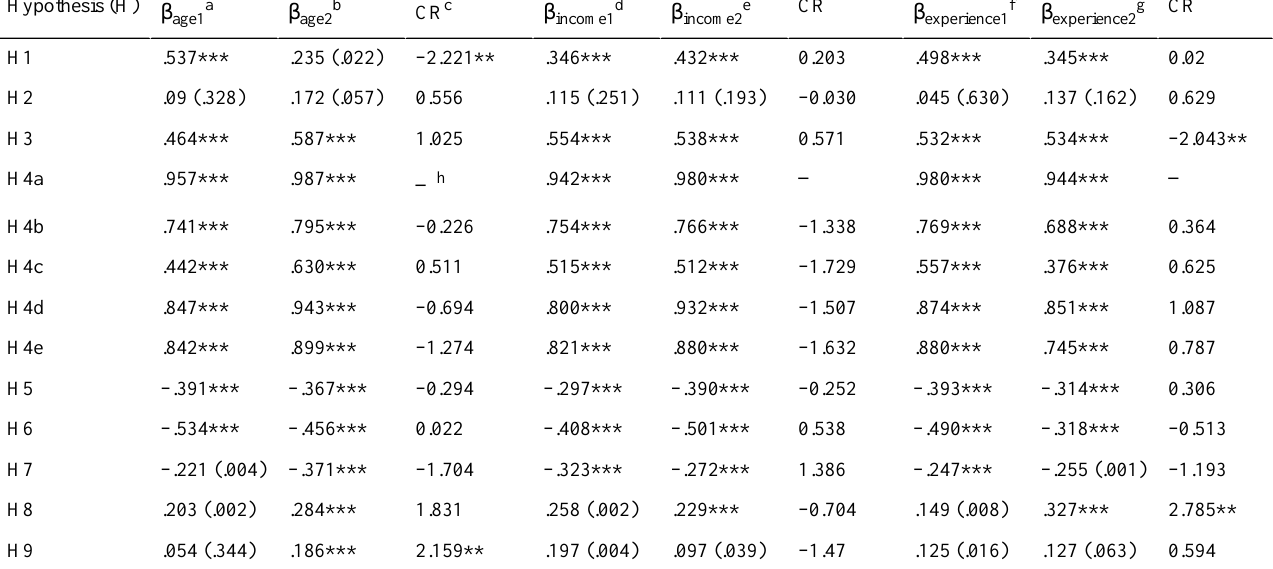
Table 7. Multiple group